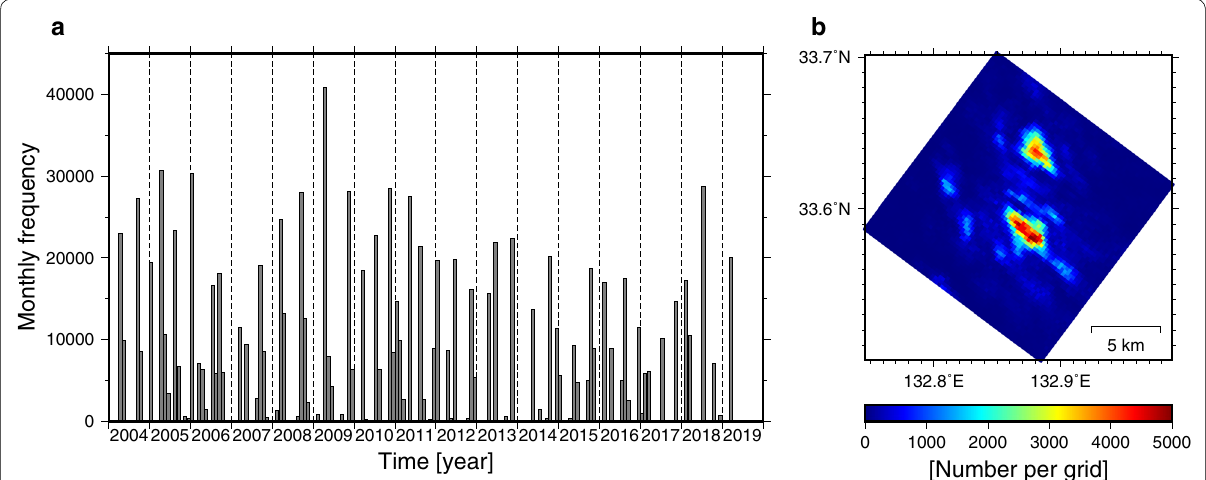
Fig. 2 Spatial and temporal distributions of detected LFEs via matched-filter analysis. a Monthly histogram of LFE frequency. b Cumulative number of events in the study region during the study period